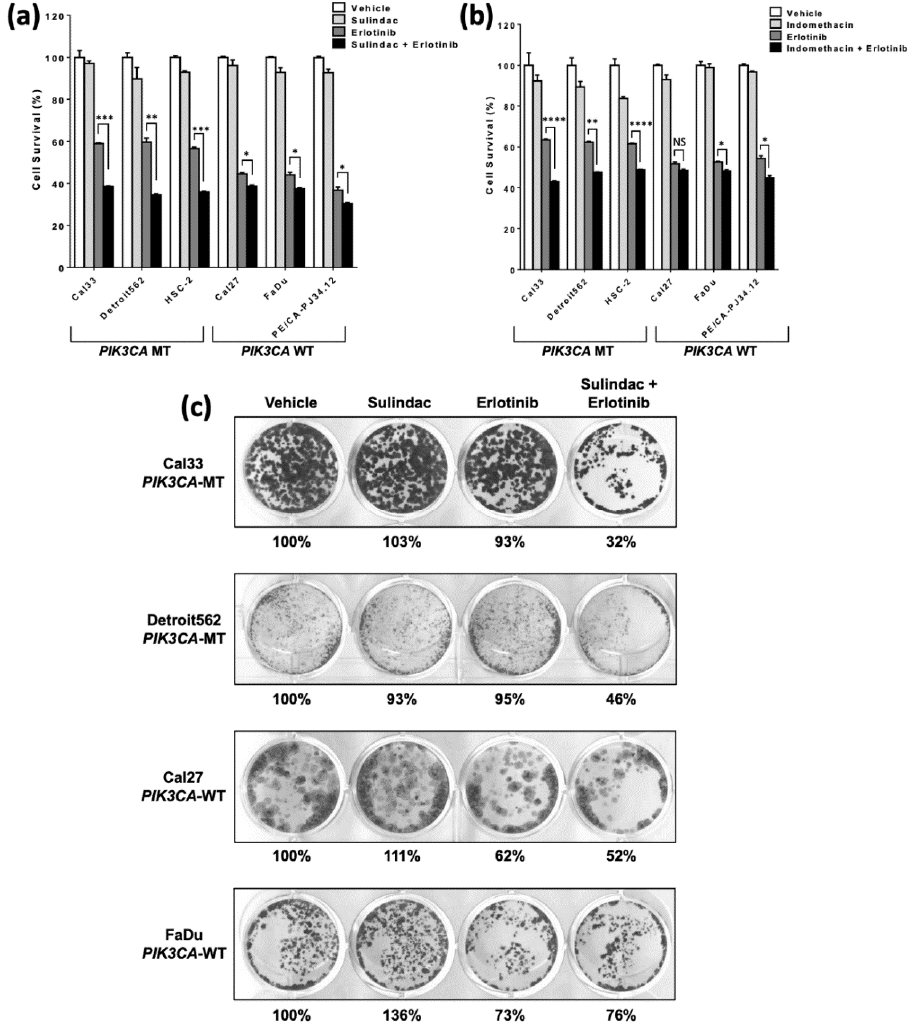
Figure 2. NSAID overcomes resistance to EGFR (erlotinib) inhibition. ( a ) HNSCC cell lines with WT PIK3CA (Cal27, FaDu, and PE/CA-PJ34.12) or PIK3CA mutation (p.H1047R; Cal33, Detroit562, and HSC-2) were treated with vehicle, sulindac (100 µ M), erlotinib (2 µ M), or a combination of sulindac and erlotinib for 48 h, followed by MTT assay. ( b ) Cells were treated as in panel A with substitution of 100 µ M indomethacin for sulindac. p values were calculated using a two-tailed T -test with Welch’s correction. * p < 0.05; ** p < 0.005; *** p < 0.0005; **** p < 0.0001; NS: not significant. Bars represent mean + SEM. ( c ) Longer-term survival was assessed by seeding an equal number of cells in 12-well plates followed by treatment, as indicated. After 10 days, cells were visualized by crystal violet staining and counted using ImageJ software. Percentages indicate the number of colonies relative to vehicle